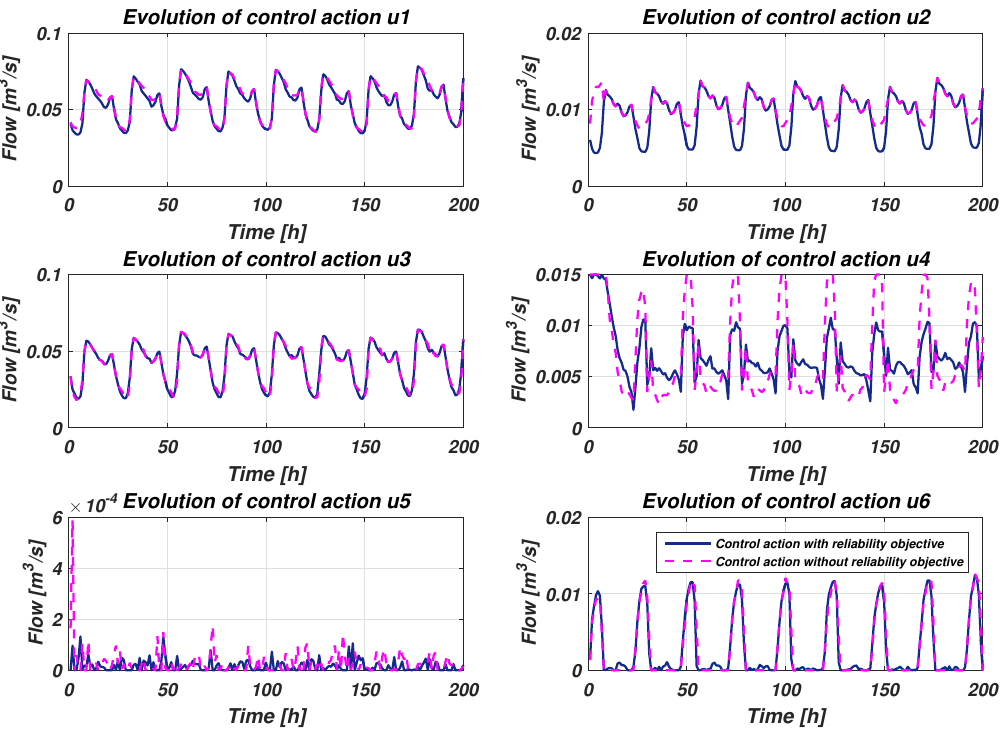
Figure 4. Evaluation of the control actions results for three tanks.